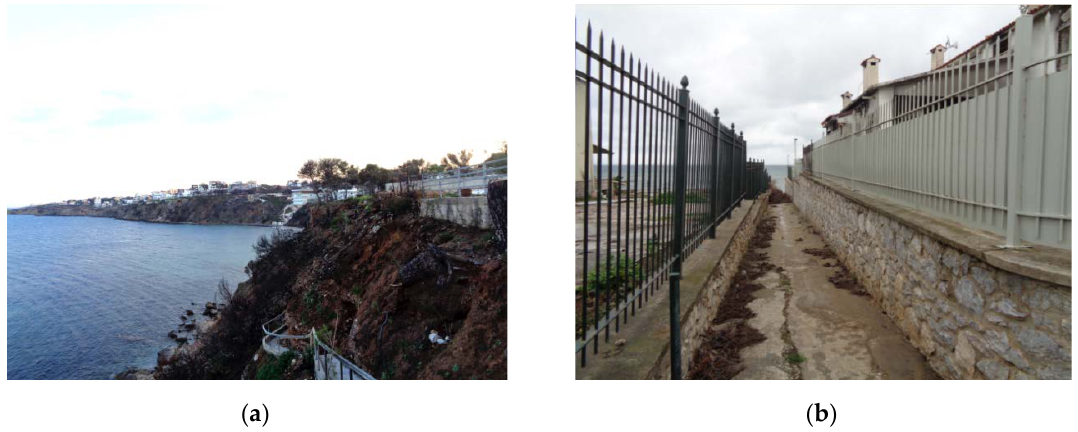
Figure 3. Pictures of Mati after the fire: ( a ) Coastal area; ( b ) narrow path leading toward the sea.